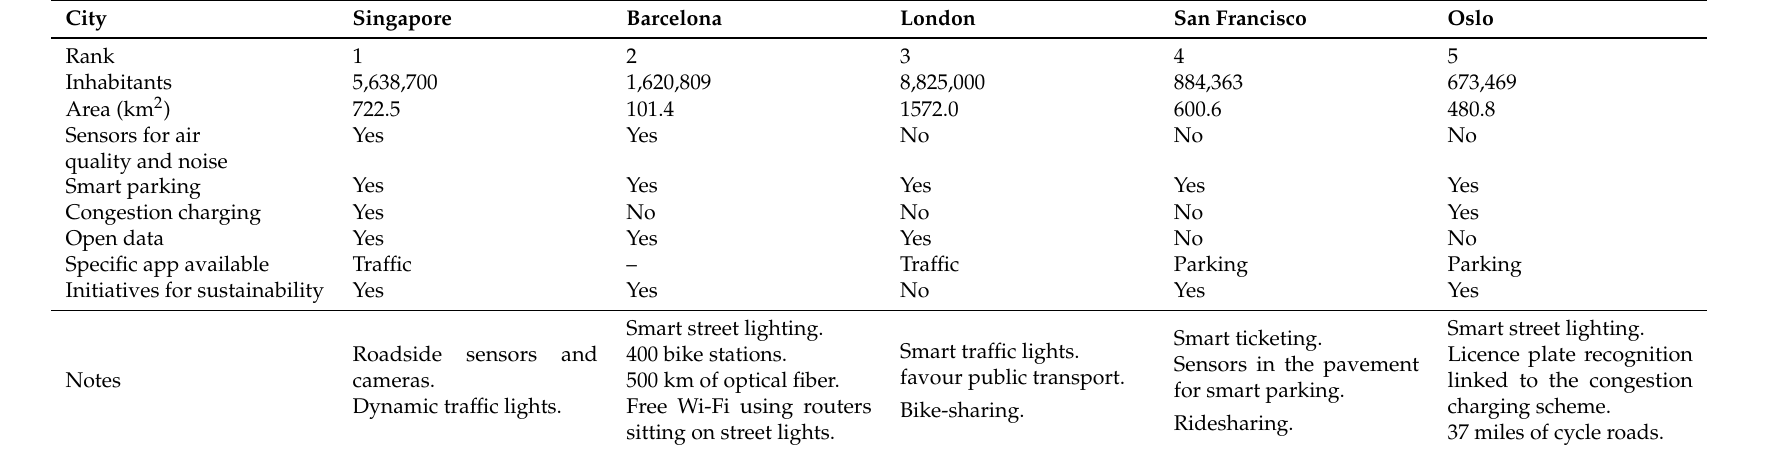
Table 2. Features related to smart traffic in the top five smart cities in the world (data as of